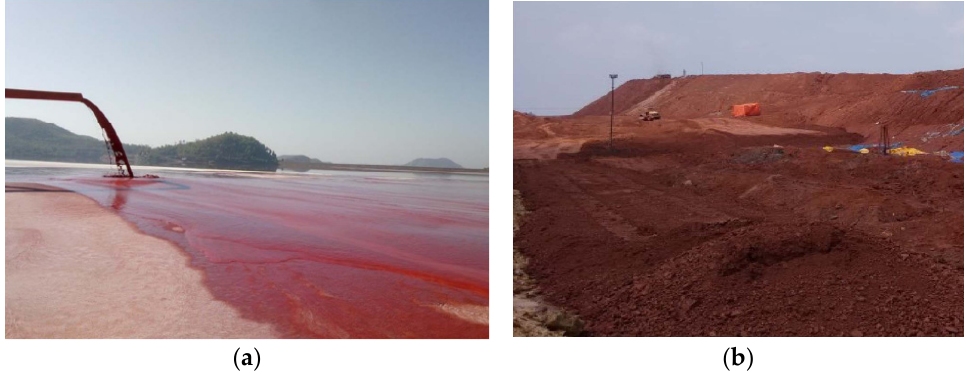
Figure 1. Discharge and stacking of red mud. ( a ) Mud treatment. ( b ) Dry mud